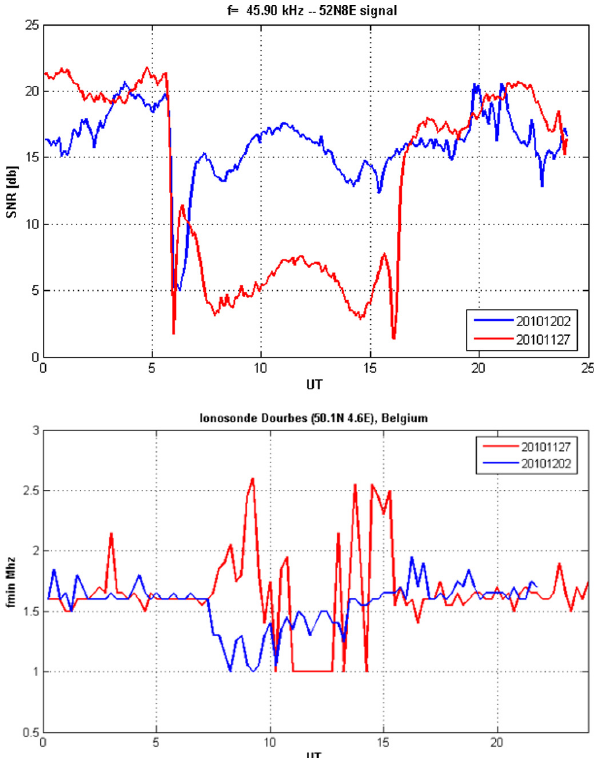
Fig. 1. Forcing from below: winter anomaly (strong absorption) during daytime for VLF/LF and HF radio waves; top: VLF/LF log amplitude (signal to noise ratio, dB), 45.9kHz, (NSY-52N8E, red: 27 November 2010) cp. to nearby day with low absorption (blue 2 December 2010); bottom: f min (minimum frequency of ionogram echoes) for the same days from the ionosonde (URL: http://digisonde.oma.be) at Dourbes, Belgium (50.1 ◦ N, 4.6 ◦ E), high f min indicating strong HF absorption.